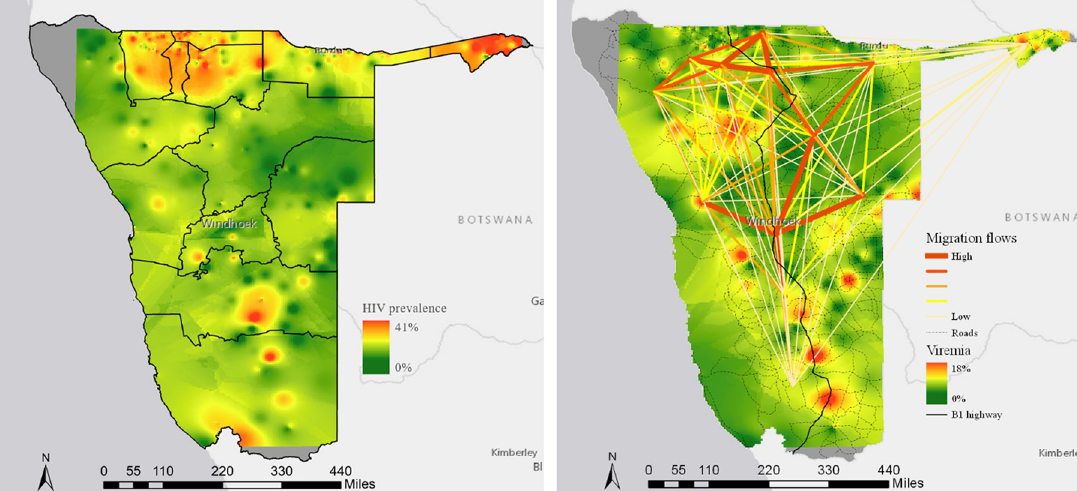
Fig 1. Distribution of HIV infection, and viremia across Namibia, 2017. a) Prevalence of HIV in Namibia, 2017. Maps with spatial interpolation to estimate prevalence of each outcome in adults aged 15–64 years using inverse density weighting (Namibia, 2017). (a) Weighted HIV prevalence (%) in adults. b) Prevalence of HIV viremia with migration flows overlaid. Weighted prevalence of HIV viremia in all adults (i.e., proportion of the population with an HIV viral load > 1000 copies/mLml, regardless of serostatus). The migration flows were derived from Worldpop micro-census data. The black line indicates the B1 highway from South Africa to Angola.